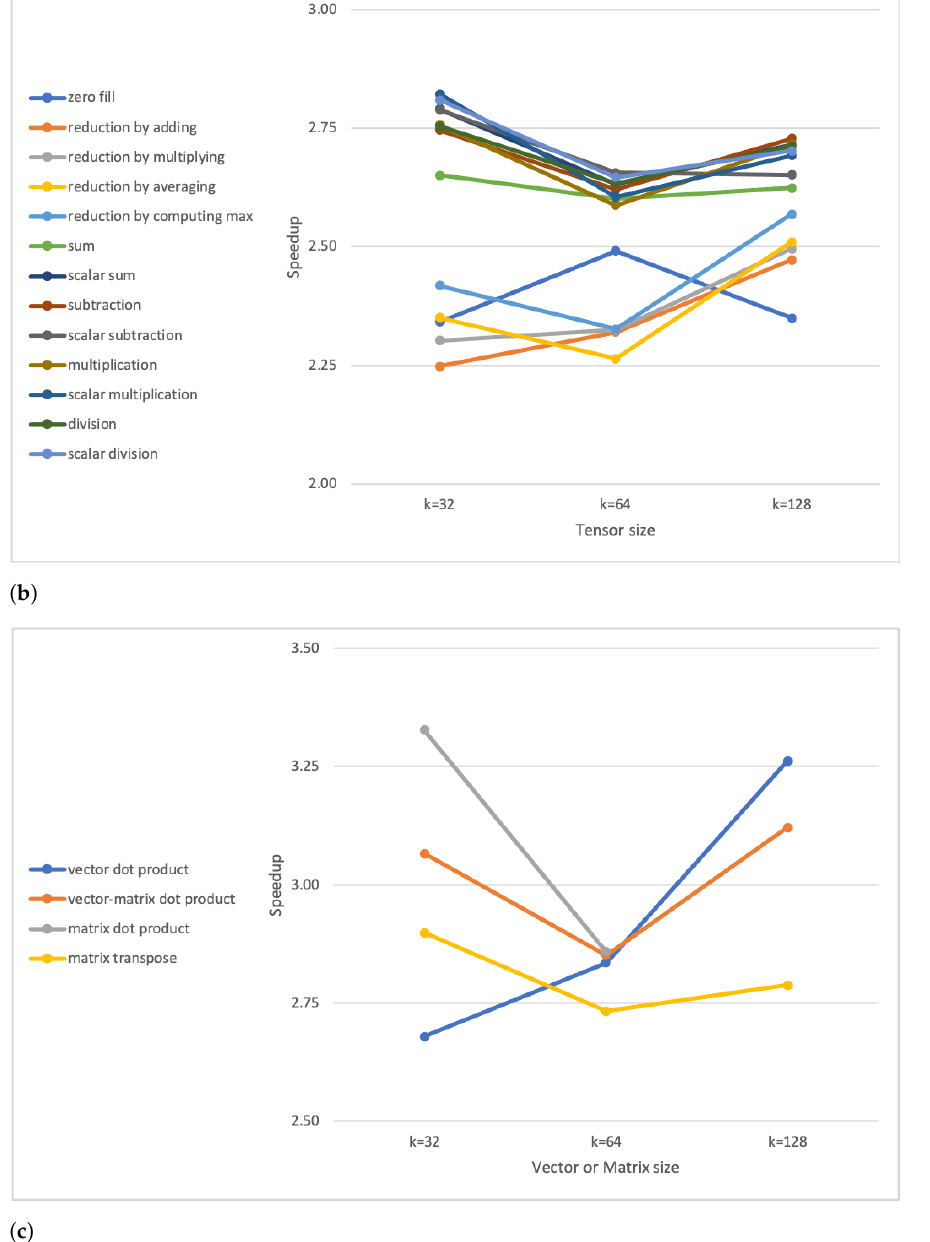
Figure 13. Computed average speedups for ( a ) rank 1 tensor operations, ( b ) rank 2 tensor operations, and ( c ) vector or matrix